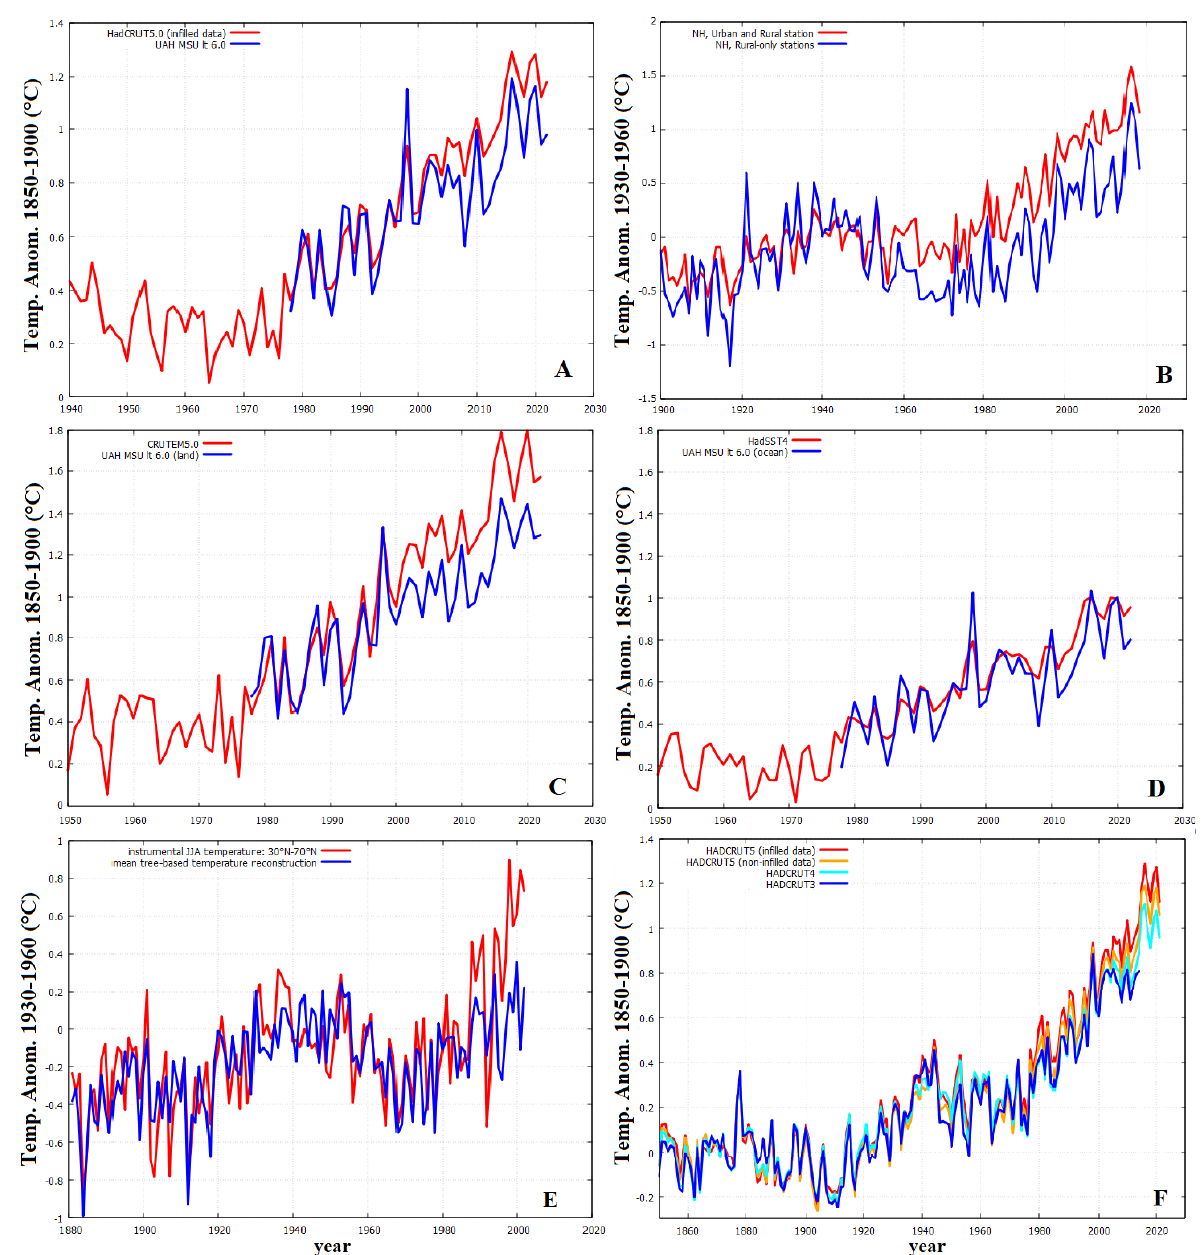
Figure 5. Evidence suggesting that the global surface temperature records (red curves) may be warm biased, in particular, over land. ( A ) Divergence between HadCRUT5 (infilled data, red) [22] and the UAH-MSU-lt 6.0 [29] temperature records (blue). ( B ) Divergence between Northern Hemisphere land temperature records using urban and rural stations (red) and rural only stations (blue), from Connolly et al. [27]. ( C , D ) compare the CRUTEM 5.0 (land) [46] and the HadSST4 (ocean) [47] records versus the land and the ocean records of UAH-MSU-lt v. 6.0 [29], respectively; the UAH- MSU-lt records were baselined with the surface records in the period 1980–1990. ( E ) Divergence between the summer (JJA) instrumental temperatures averaged over 30 ◦ N–70 ◦ N land areas (red) and the tree-based mean temperature reconstructions (blue) relative to the 1930–1960 period [48]. ( F ) Divergence among the HadCRUT3 (1850–2014), HadCRUT4 (1850–2021), HadCRUT5 (non-infilled data, 1850–2021), and HadCRUT5 (infilled data, 1850–2021) global surface temperature records relative to the 1850–1900